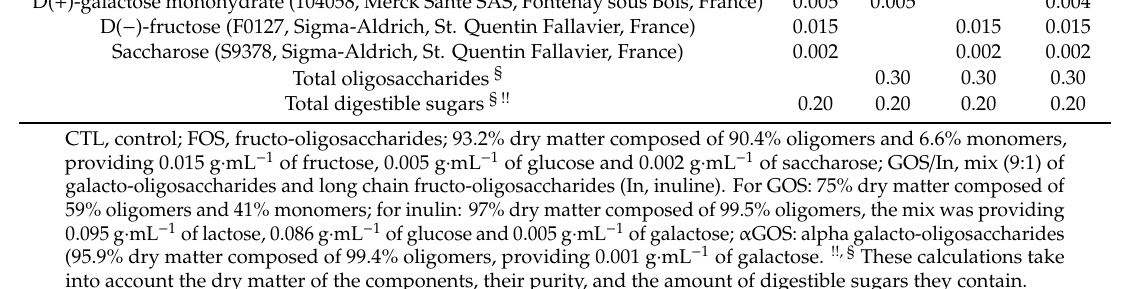
Table 1. Composition of solutions administered by gavage to pups from PND5 to PND14 / 15 (g · mL − 1 ). CTL FOS GOS / In α GOS GOS syrup (VivinalGOS, FrieslandCampina Domo, LE Amersfoort, 0.65 The Netherlands) Inulin powder (Raftiline HP, BENEO-Orafti S.A., Tienen, Belgium) 0.03 FOS powder (Beneo P95, BENEO-Orafti S.A., Tienen, Belgium) 0.34 α GOS powder (Olygose, Venette, France)